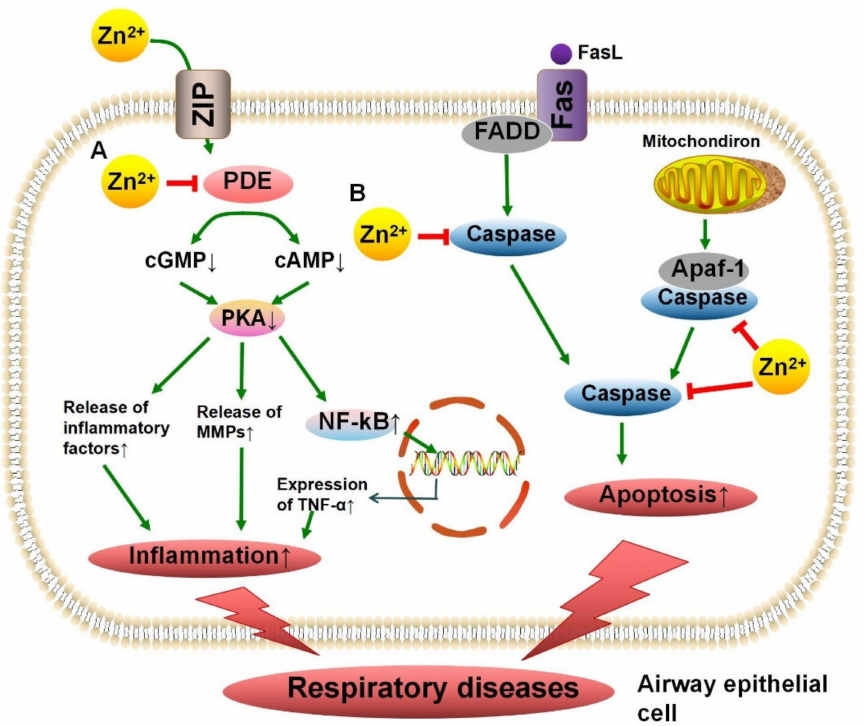
Figure 3. The protective mechanism of Zn 2+ on respiratory diseases. Zn 2+ can enter airway epithelial cells via ZIP. ( A ) PDE is responsible for catalyzing the degradation of cGMP and cAMP. Reduced cGMP and cAMP lead to reduced PKA activation, which in turn promotes downstream inflammatory cascades and increased TNF- α expression. Combination of Zn 2+ and PDE can inhibit the enzyme activity, which reduces the cell damage caused by inflammation. ( B ) Exogenous apoptosis is mediated by FasL and Fas, while endogenous apoptosis is mediated by mitochondria. Both pathways activate initiator and executioner caspases to promote apoptosis. Zn 2+ protects the airway epithelium by inhibiting caspase activity to prevent excessive cell death. ZIP, Zrt- and Irt-like protein; PDE, phosphodiesterase; FasL, Fas ligand; Fas, tumor necrosis factor receptor superfamily member 6; FADD, Fas-associated death domain; PKA, protein kinase A; NF-Kb, nuclear transcription factor- kappa